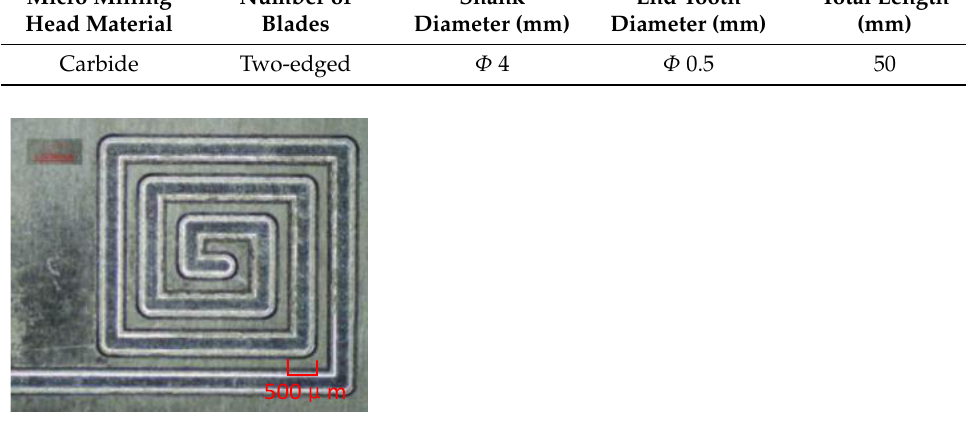
Figure 23. Micro-structure after micro-milling.